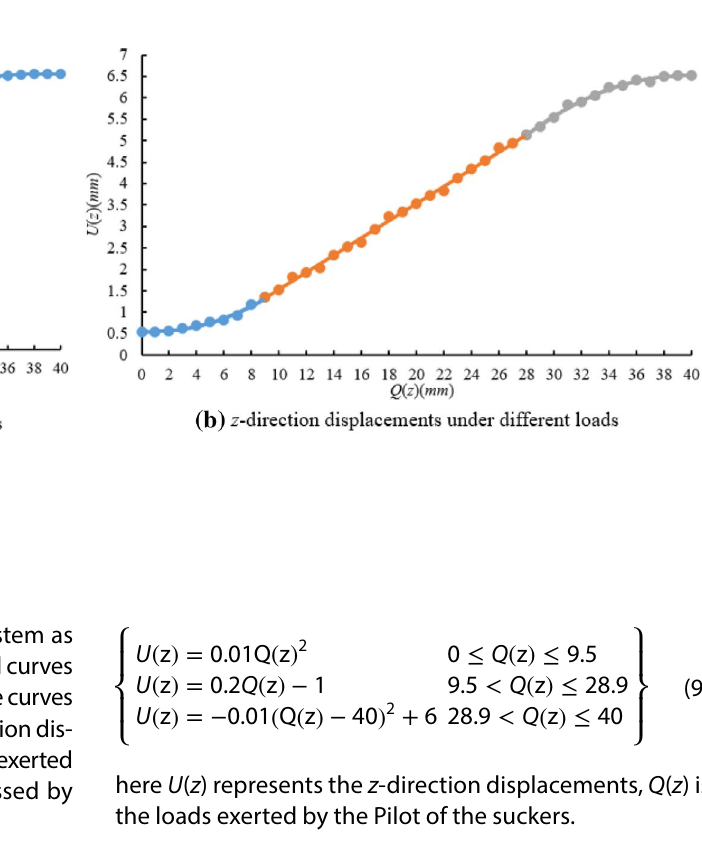
Table 2 Relative displacement deviations when the load is 10 mm